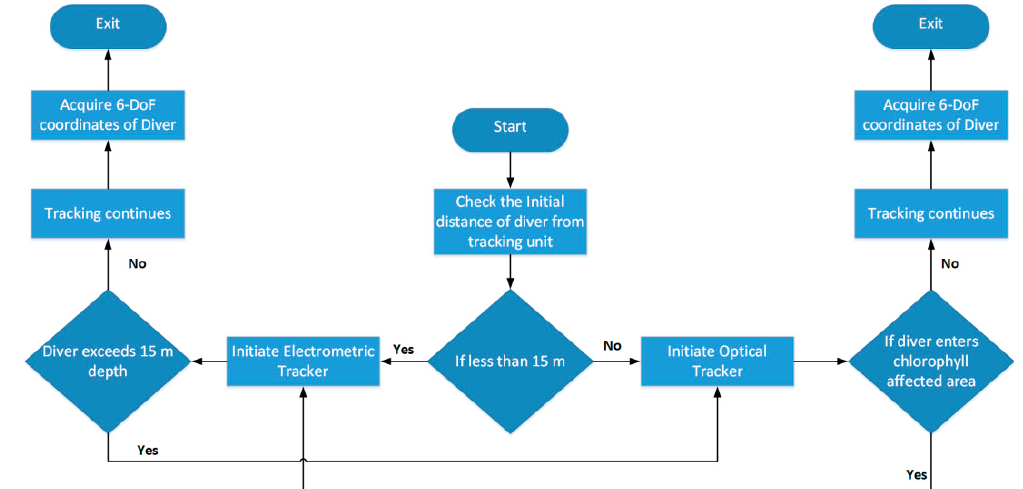
Figure 12. Flowchart of working of hybrid underwater diver tracking system.